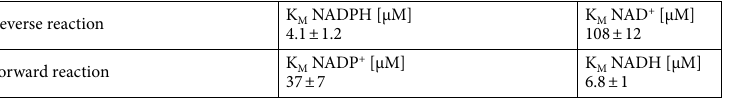
Table 1. K M values determined for all substrates in the reverse and forward reactions. The respective initial reaction velocities were analysed in a double reciprocal plot with the corresponding nucleotide concentration (Lineweaver–Burk Plot). Shown are averaged values and standard deviations from measurements of three enzyme preparations.